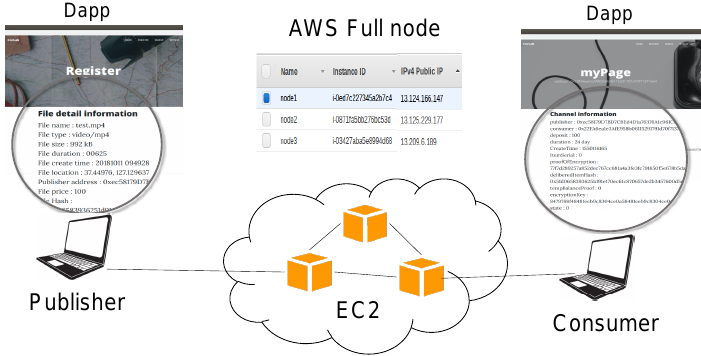
Figure 7. Implementation and testbed of the autoCoin